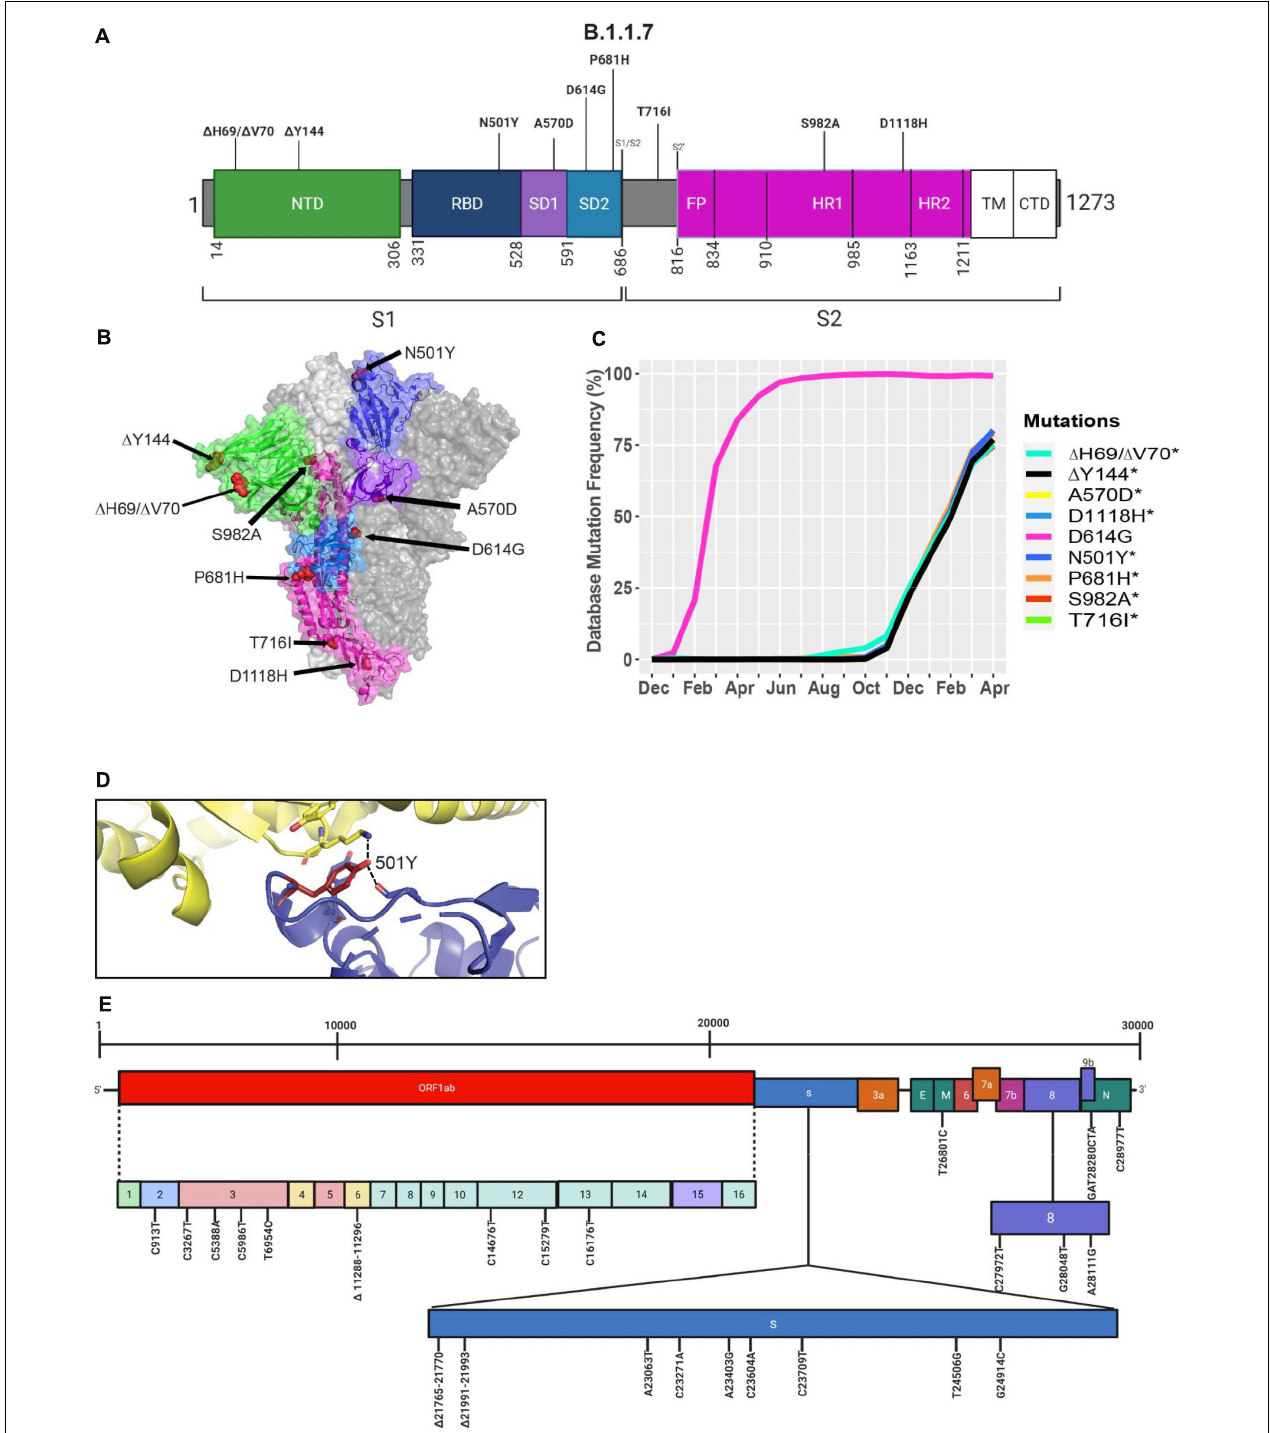
FIGURE 5 | Analysis of mutations in the B.1.1.7 variant. (A) Mutation map of the spike protein of B.1.1.7. (B) Structural representation of spike with ACE2. B.1.1.7 S protein mutations are presented in red. N-terminal domain (NTD) (green), receptor-binding domain (RBD) (blue), SD1 (purple), subdomain 2 (SD2) (light blue), and S2 (magenta) are illustrated. The other S protein monomers are displayed in gray and white. (C) Frequency of the mutations in the S protein, B.1.1.7 variant from December 2019 to April 30, 2021. (D) Interaction of the N501Y (red) mutation in the RBD (blue) of S protein with hACE2 (yellow). The dash lines indicate interactions with adjacent residues. (E) Genome of the SARS-CoV-2 B.1.1.7 variant with identified nucleotide substitutions and deletions. Graphs were generated using Biorender, PyMOL, and RStudio. *Overlapping